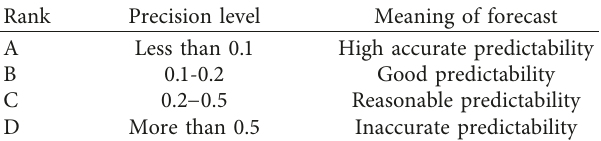
Table 1: The standard levels of MAPE (%) model evaluation